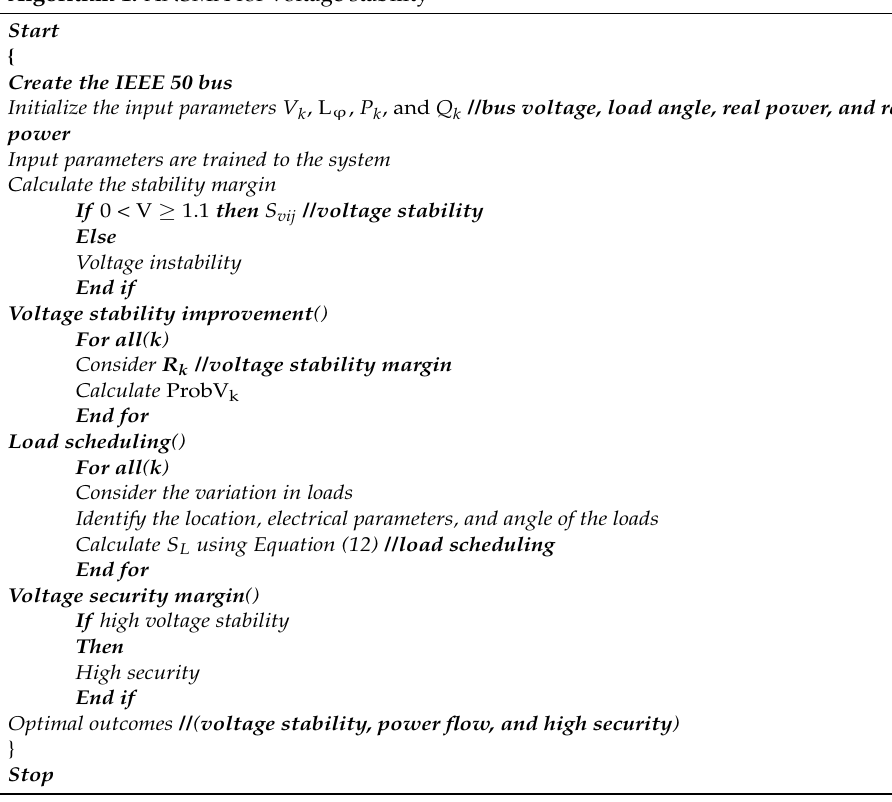
Algorithm 1: ANSMA for voltage